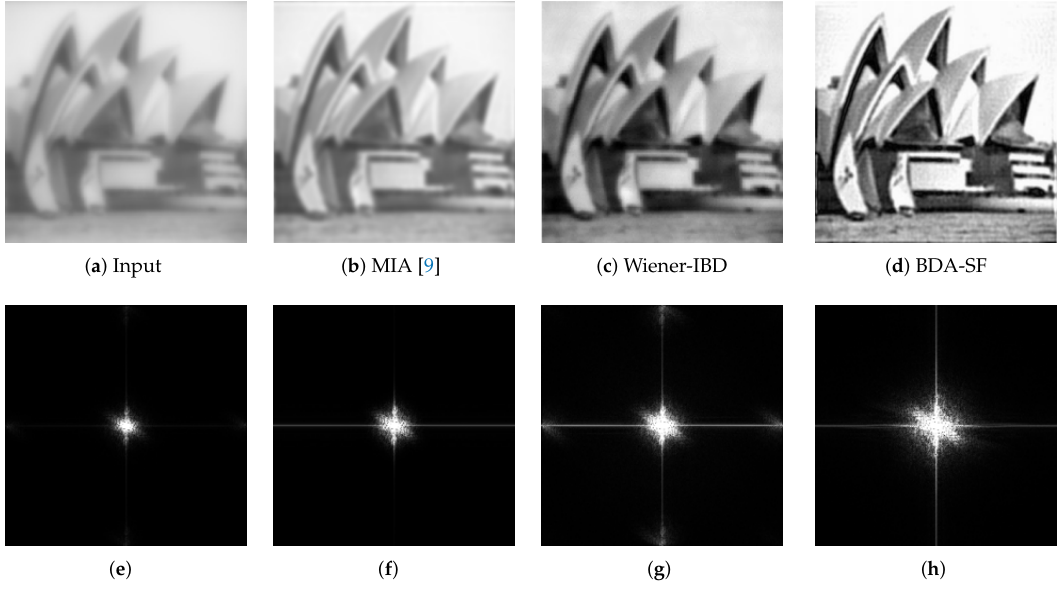
Figure 8. The proposed algorithm is compared with other general algorithms. ( a ) an actual blurred image. ( b ) Multiplicative iterative algorithm. ( c ) Wiener-IBD. ( d ) the proposed BDA-SF. ( e – h ) are the corresponding spectra.